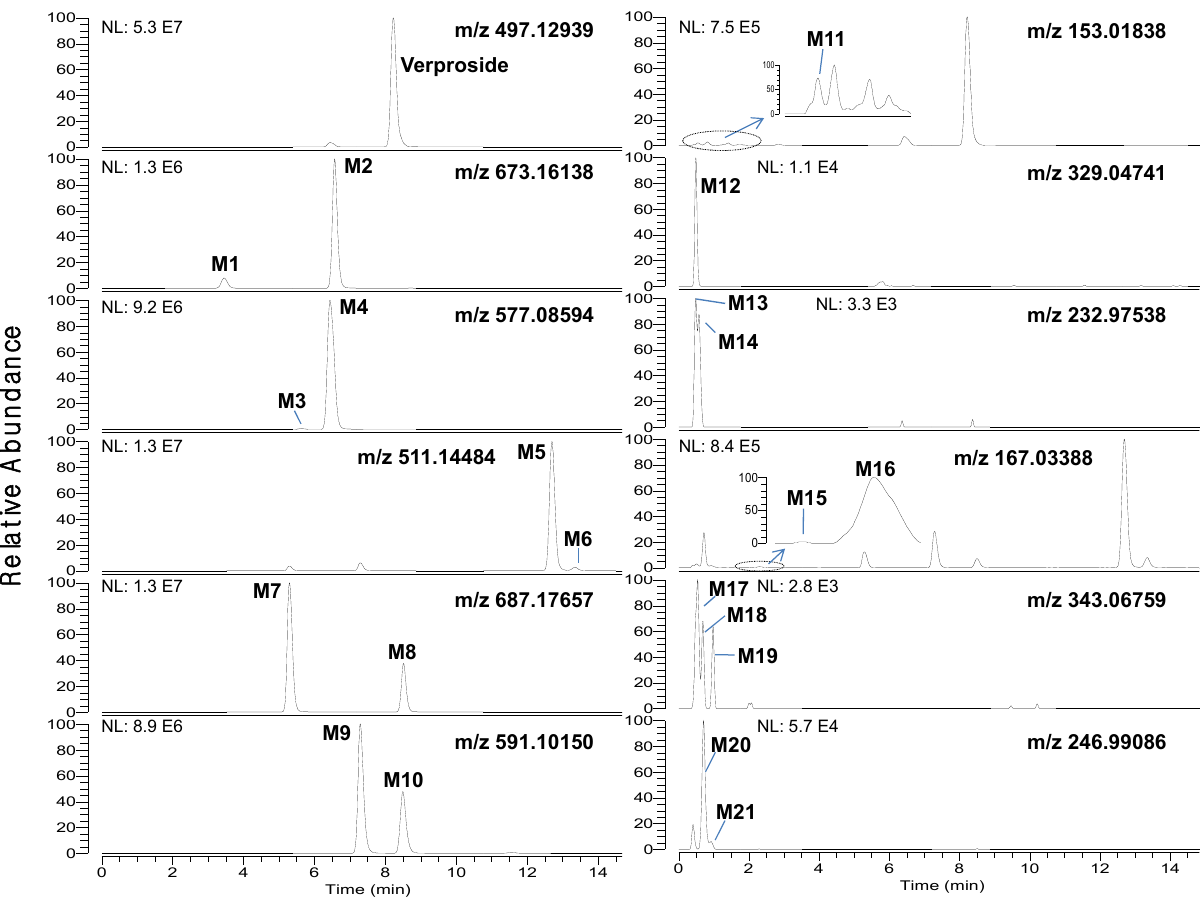
Figure 2. Extracted ion chromatograms of verproside and its possible metabolites in the urine samples obtained for 6 hours after intravenous administration of verproside at a dose of 10 mg/kg to a Sprague Dawley